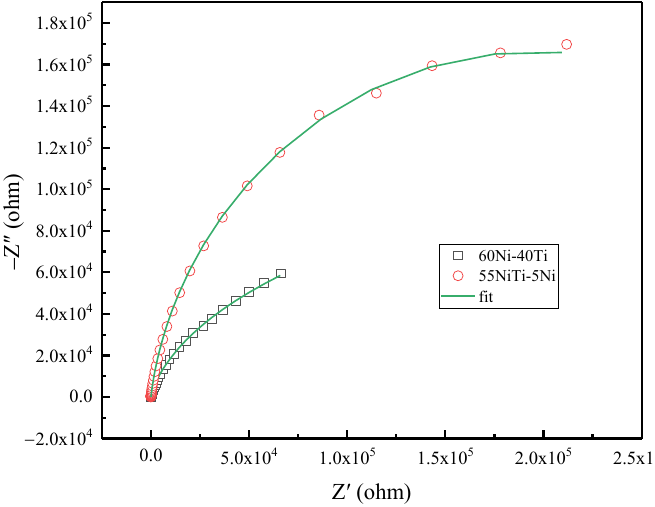
Figure 13. Nyquist plots of coatings.